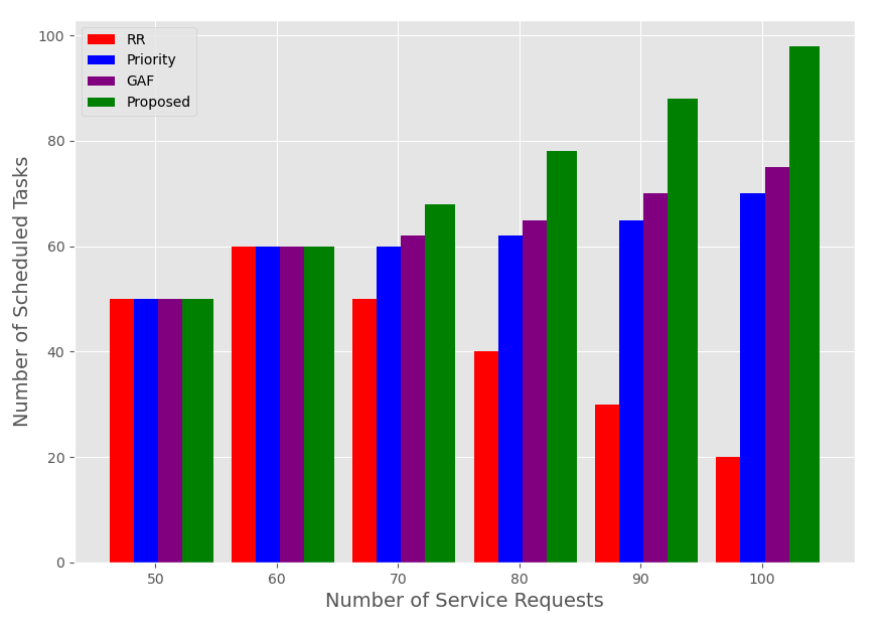
Figure 13. Performance evaluation by using number of service requests with the scheduled tasks.